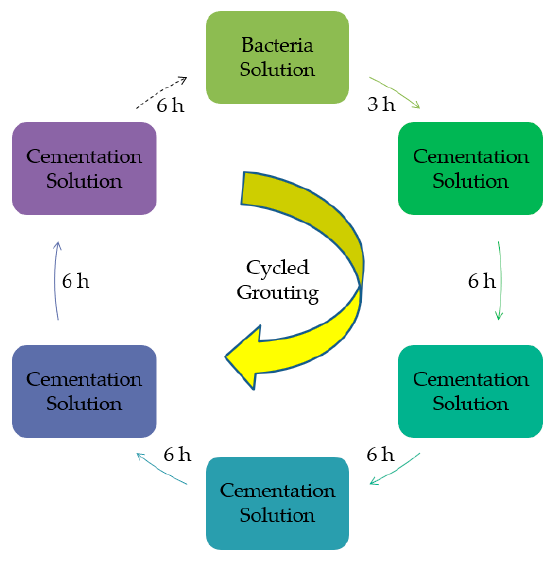
Figure 3. Grouting procedure.